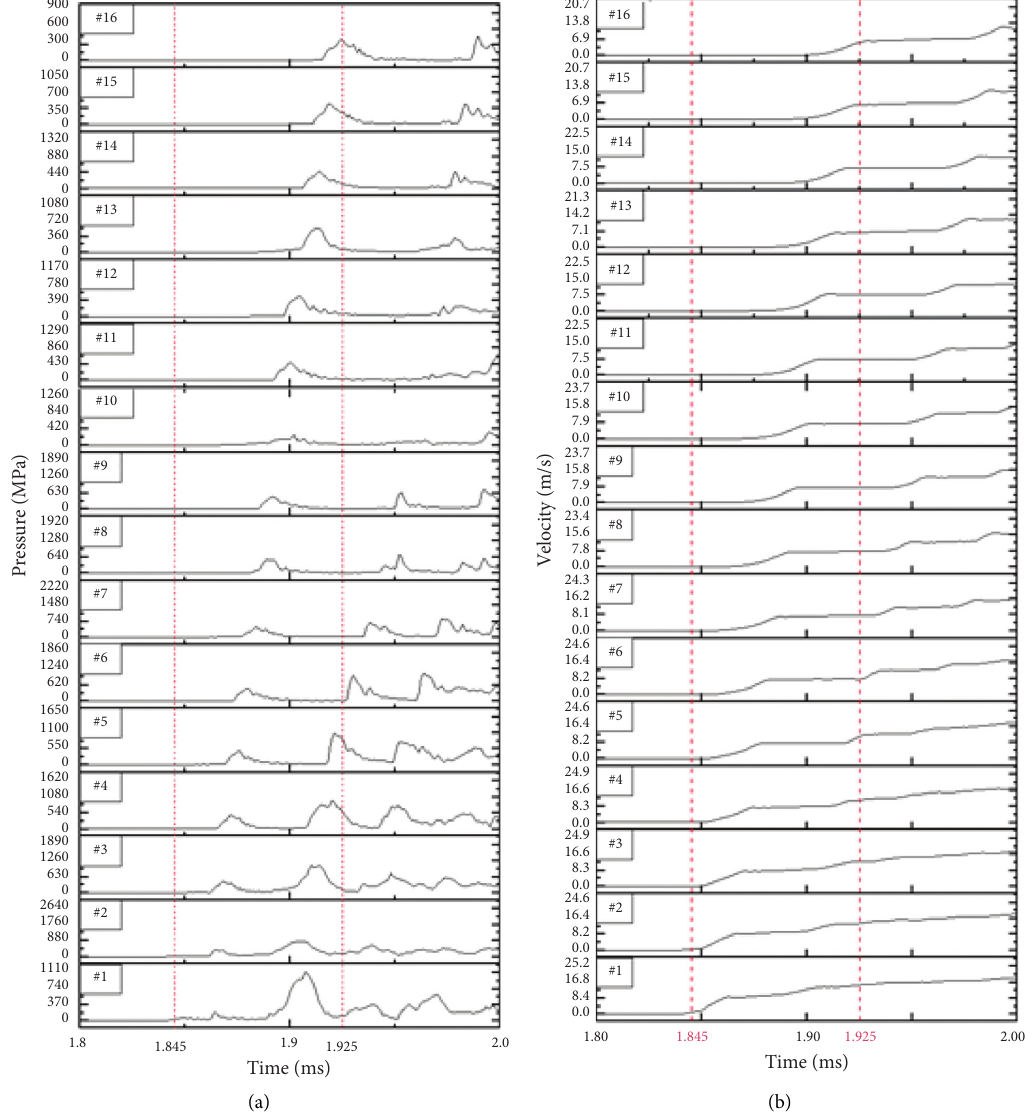
Figure 13: Stress and velocity histories of every particle